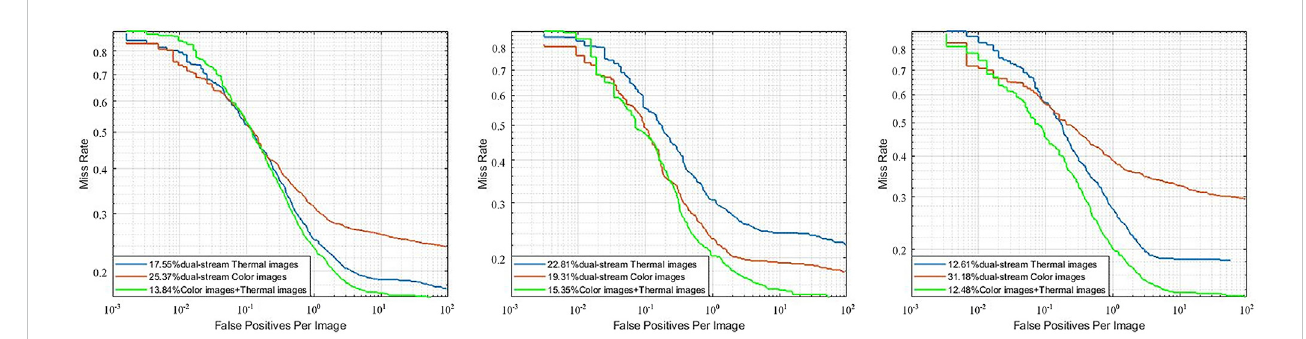
FIGURE 4 The Miss Rate-FPPI curves of the detection results of the three groups of input sources in the All-weather, Daytime and Nighttime scenes (From left to right, All-weather, Daytime and Nighttime Miss Rate-FPPI curves are shown in the fi gure).